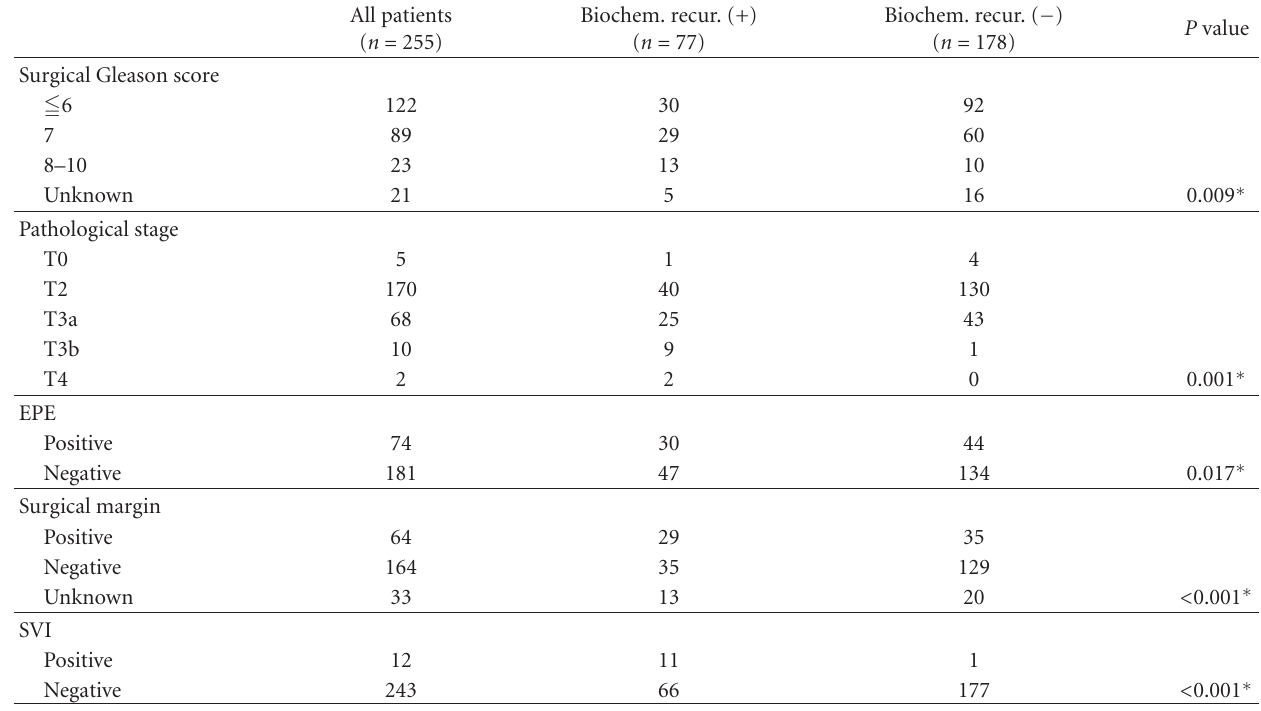
Table 2: Postoperative clinicopathological